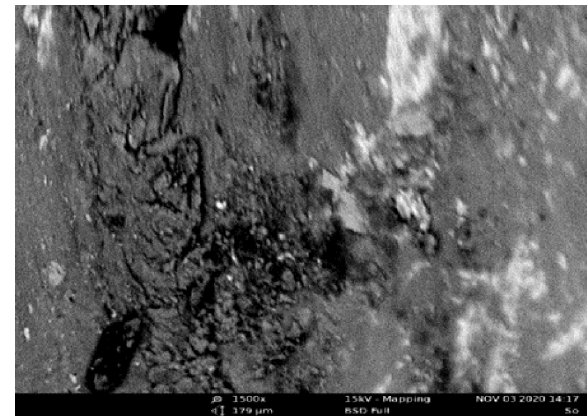
Figure 10: SEM Result of the blank mild steel.